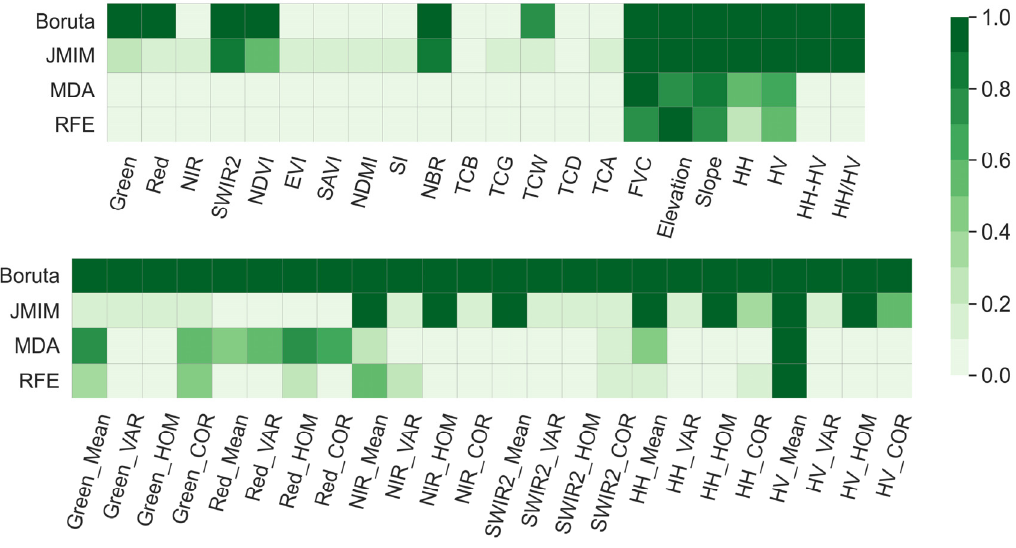
Figure 3. Frequency of features contained in the 50 feature subsets produced by Boruta, JMIM, MDA and RFE.